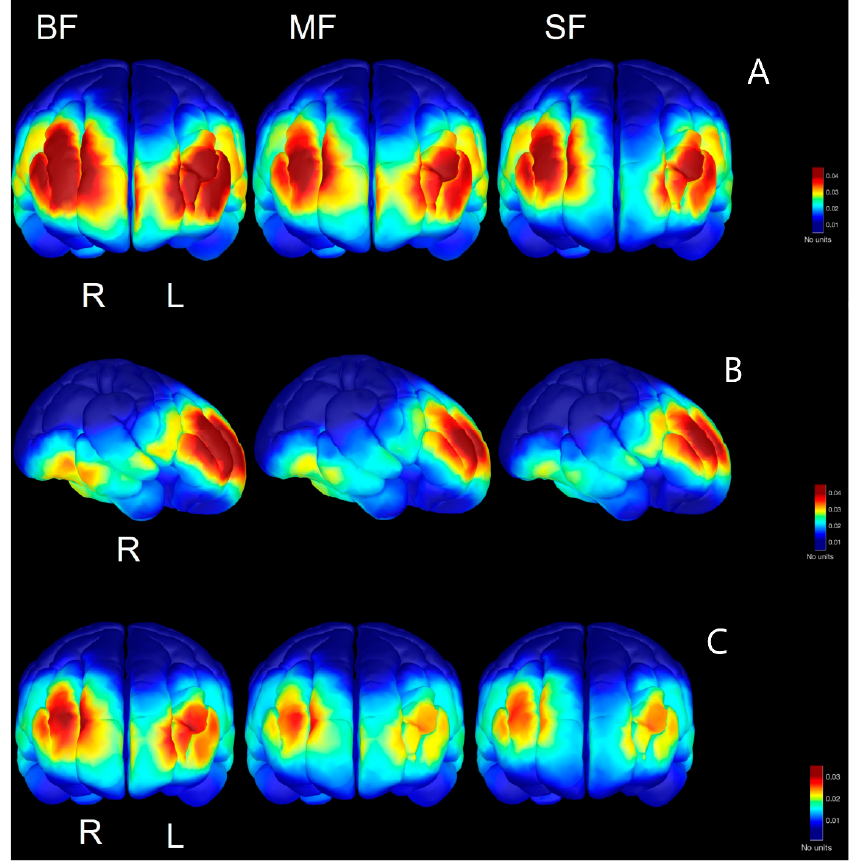
Figure 4. Source space reconstruction of the average power of beta ( A , B ) and gamma ( C ) frequency bands in 6-month-olds based upon dietary group. Prefrontal activation is observed in A and C while right, temporal activation is observed in B.